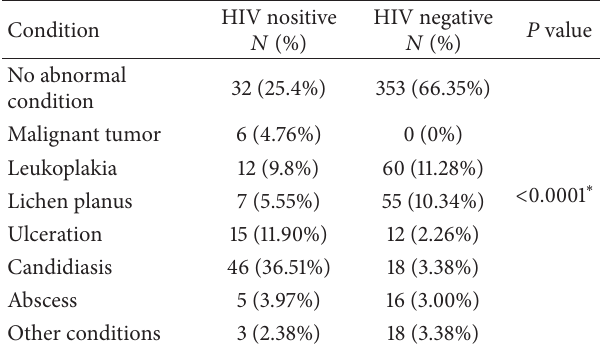
Table 3: Oral-mucosal lesions between HIV positive and negative